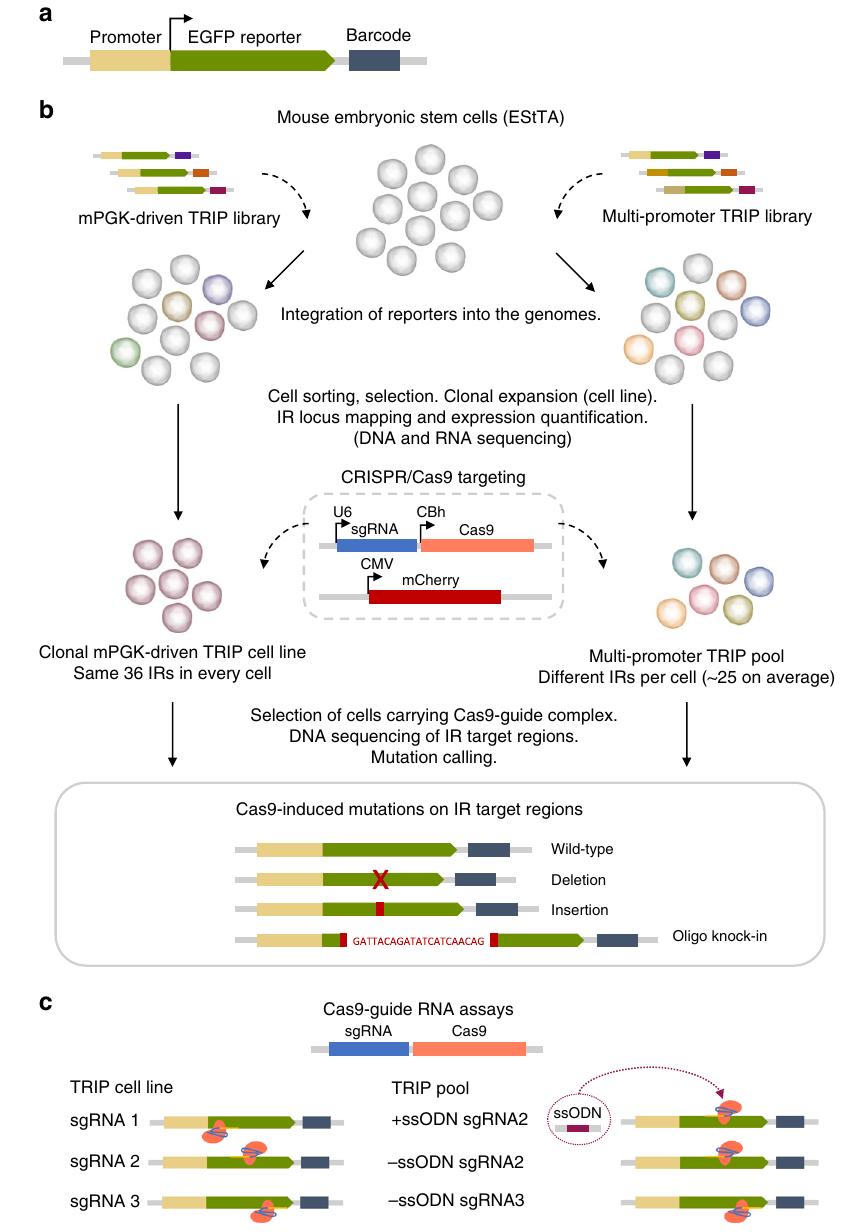
Fig. 1 Overview of CRISPR-Cas9 assays in TRIP cell line and pools. a Barcoded TRIP reporter construct. b Clonal PGK-driven TRIP cell line with 36 IRs (left), and TRIP pool containing ~ 1k IRs with various promoters (right) - CMV, cMyc, Hoxb1, Nanog, Oct4, p53, PGK. Genomic location and expression of IRs were determined by DNA and RNA sequencing prior to Cas9 targeting of IR regions using different guides. Targeted DNA sequencing of IR regions was further used to characterize mutations arising from repair of Cas9-induced DSBs. ( c ) Cas9-guide RNA combinations used in independent assays. TRIP cell line was targeted using Cas9 complexes with sgRNA1, sgRNA2 or sgRNA3 (left). In TRIP pool assays, Cas9 was complexed with sgRNA2 or sgRNA3 (right). Knock-in of a single-stranded oligodeoxynuceotide (ssODN) was performed with F-test p < 3.13 × 10 − 16 (Fig. 2a), and across TRIP pool assays with R 2 > 0.72 and F-test p < 2.16 × 10 − 16 (Fig. 2d). Correlations were lower for insertions ( R 2 (cid:1) 0 : 30) than deletions ( R 2 (cid:3) 0 : 72), likely due to the scarcity of insertion events. The highly reproducible mutation frequencies revealed consistent locus-speci fi c suscept- ibility to Cas9-induced mutations (Figs. 2a, d).